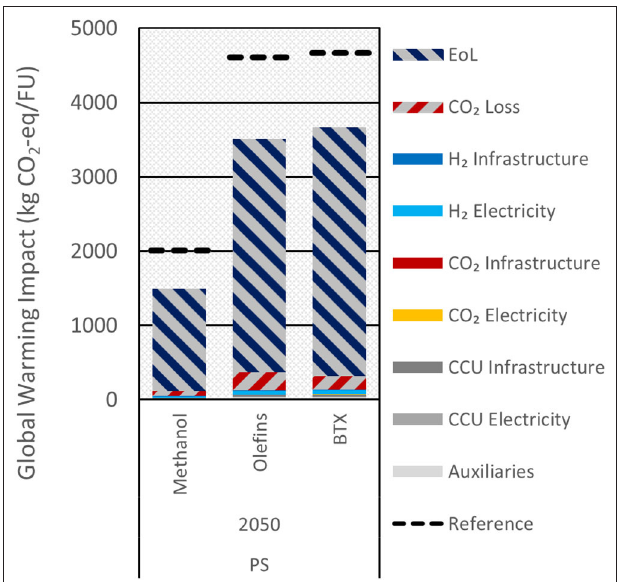
FIGURE 4 | 0:100 allocation approach for CO 2 point-sources. Contributions of process emissions and end-of-life (EoL) to the GWI for chemical production with CO 2 from point-sources (PS) in the optimized system (2050). GWI reduction is much smaller, when CO 2 from PS is allocated to the products.